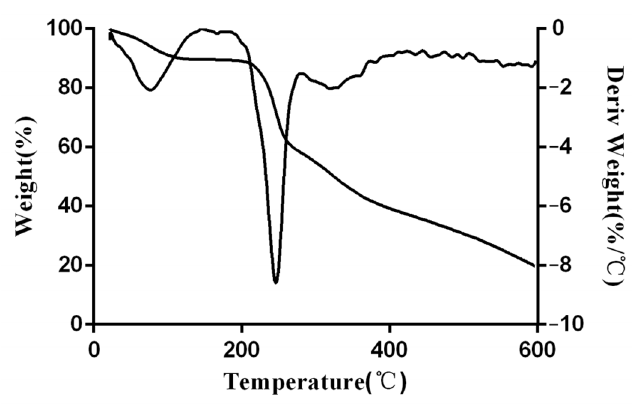
Figure 4. Thermogram curves of the EPS produced by Lpb. plantarum NMGL2.